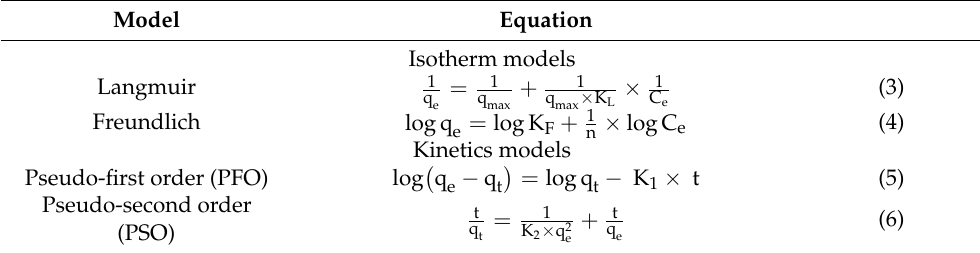
Table 1. Isotherm and kinetic models used for the experimental data.